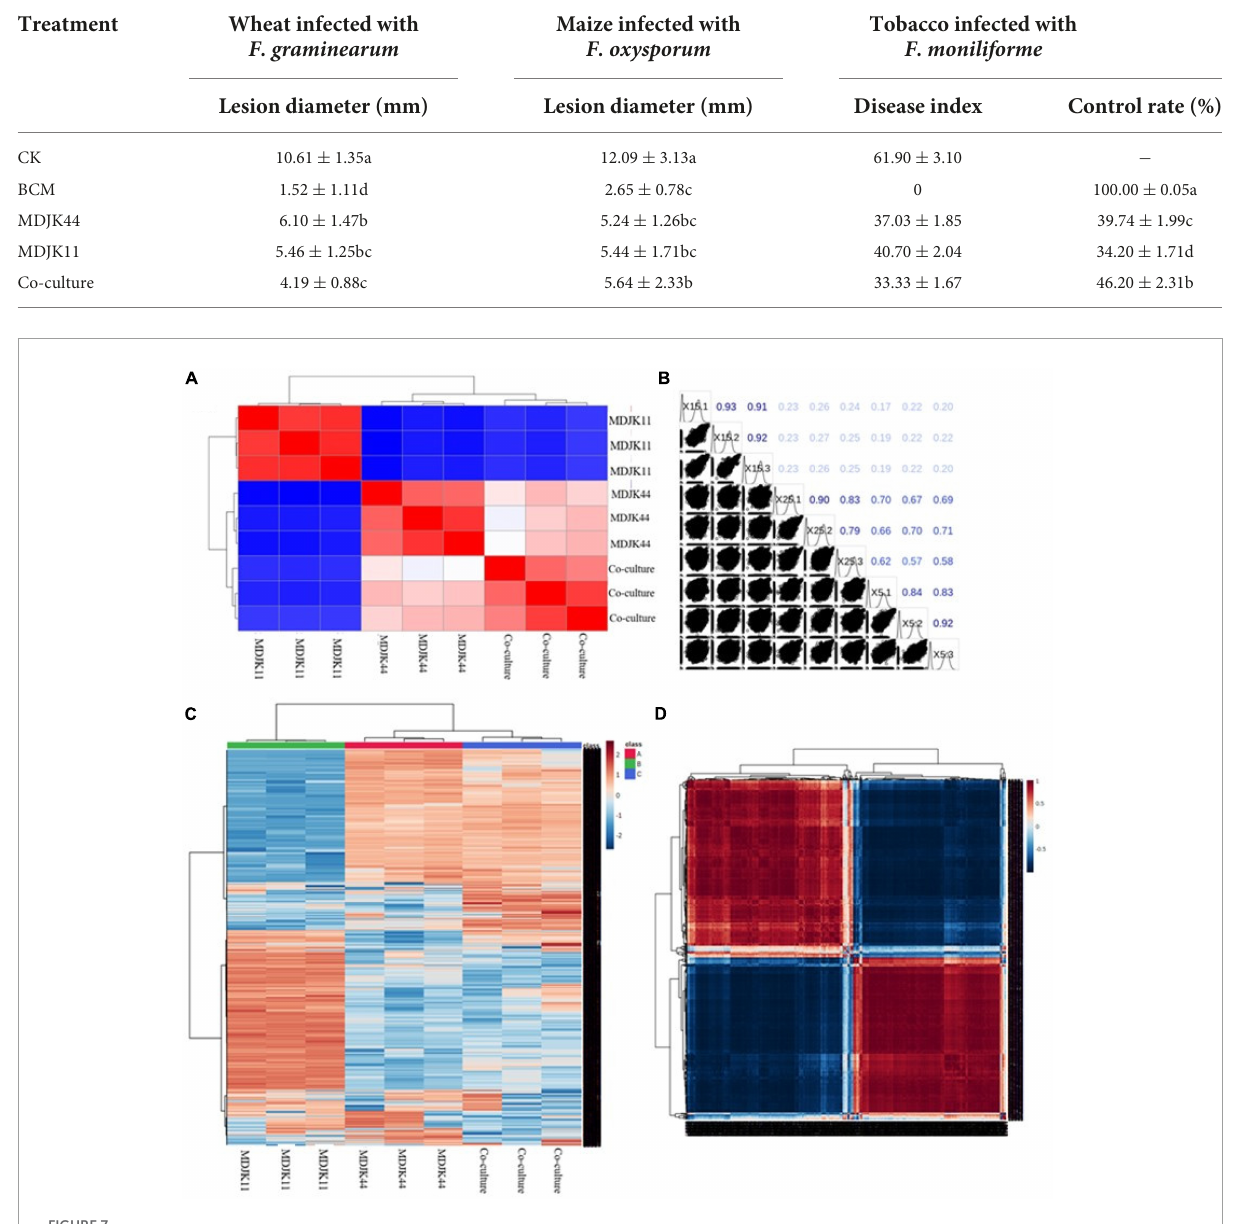
TABLE 1 Results of Streptomyces MDJK44, MDJK11 monoculture, and co-culture fermentation broth crude extract in BF4 medium on different plant diseases infected by pathogenic fungi.